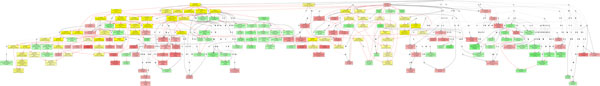
The shared GO terms and P value in Biological Process subcategory Red boxes represent GO terms that are occupied exclusively by genes on the plus strand; Green boxes represent GO terms that are occupied exclusively by genes on the minus strand, while yellow ones were common terms shared by plus and minus genes within the bi-directional gene pair. The color darkens with the significance of enrichment.